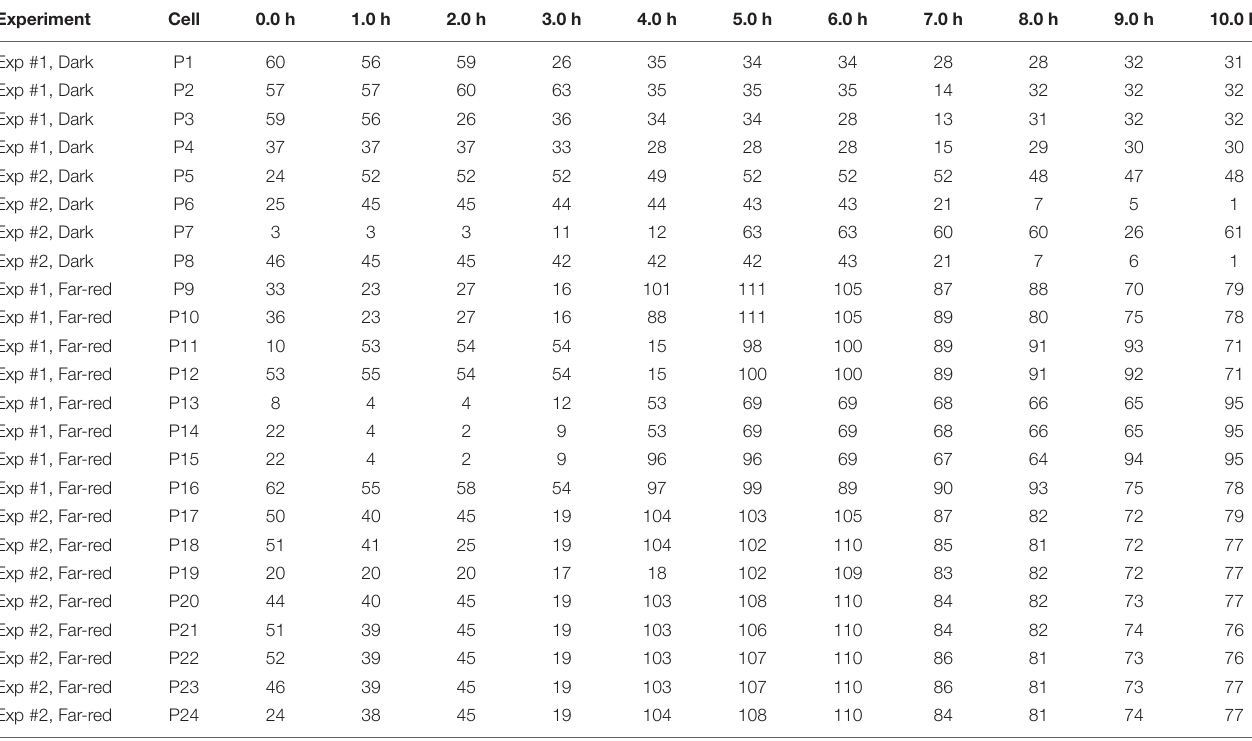
TABLE 2 | Single cell trajectories of gene expression. Experiment